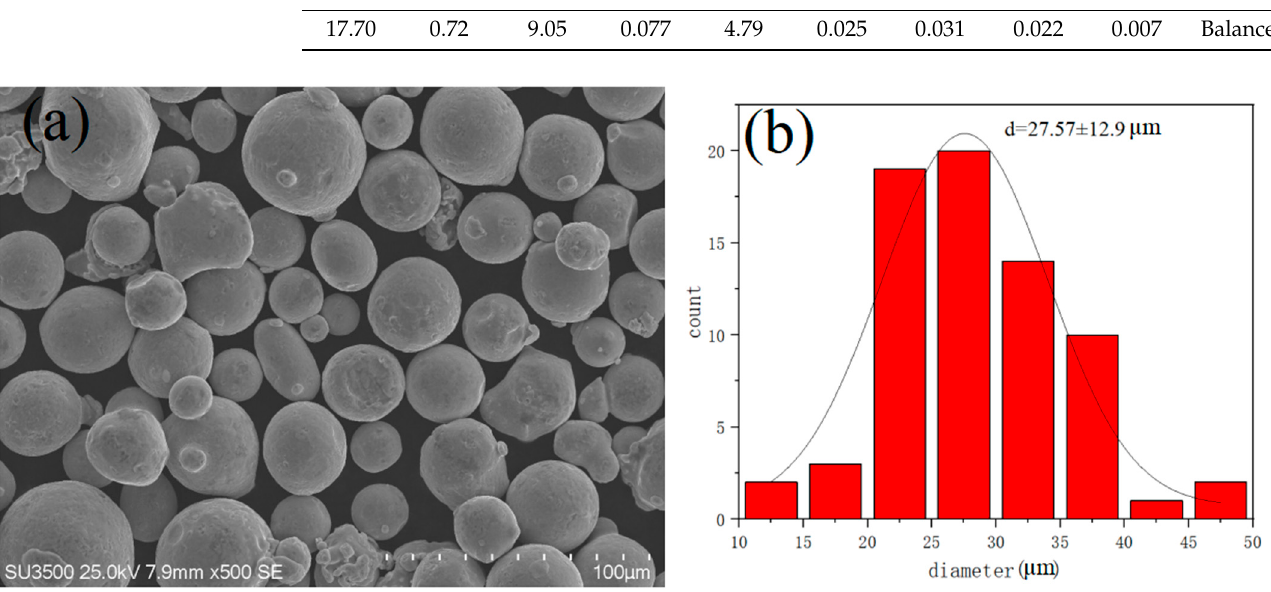
Figure 1. ( a ) Morphology and ( b ) particle diameter distribution of the 18Ni300 powder.